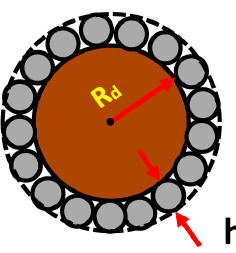
Figure 5. Composite “core-shell” droplet of a Pickering emulsion with core radius R d and interfacial layer thickness h protruding into the continuous phase.